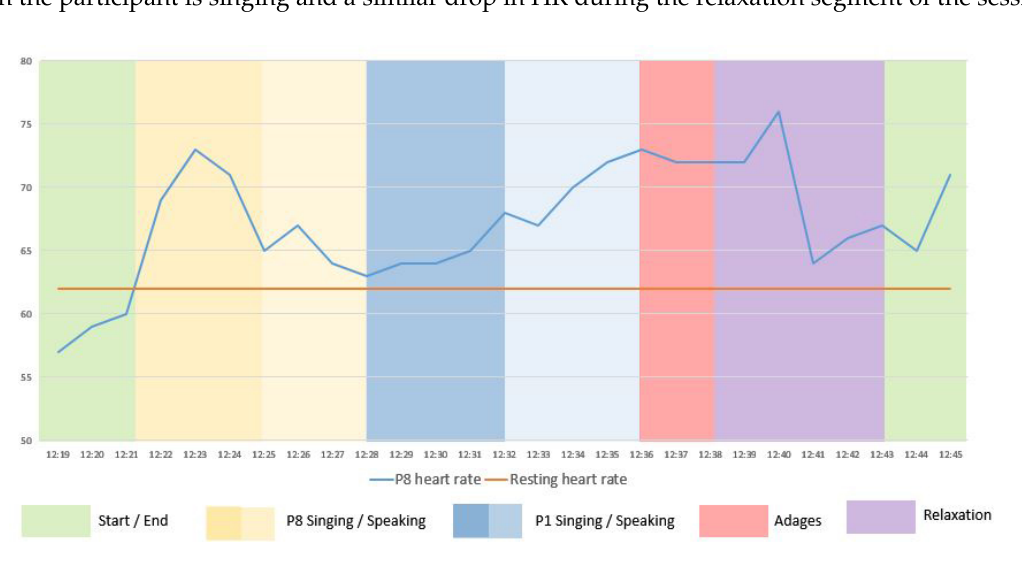
Figure 4. Average heart rate of P8 during sessions